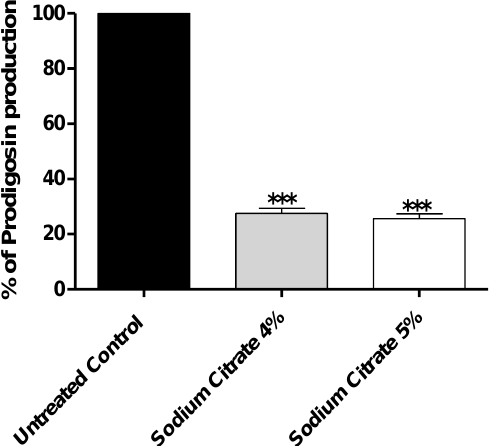
Figure 5. The effect of sodium citrate at 4% or 5% on production of prodigiosin. Citrate at 4% or 5% significantly diminished production of prodigiosin; the inhibition percentages were about 70%. The data are presented as percentage change from control, and One-way ANOVA test was employed to assess significance; ***: p ≤ 0.001.